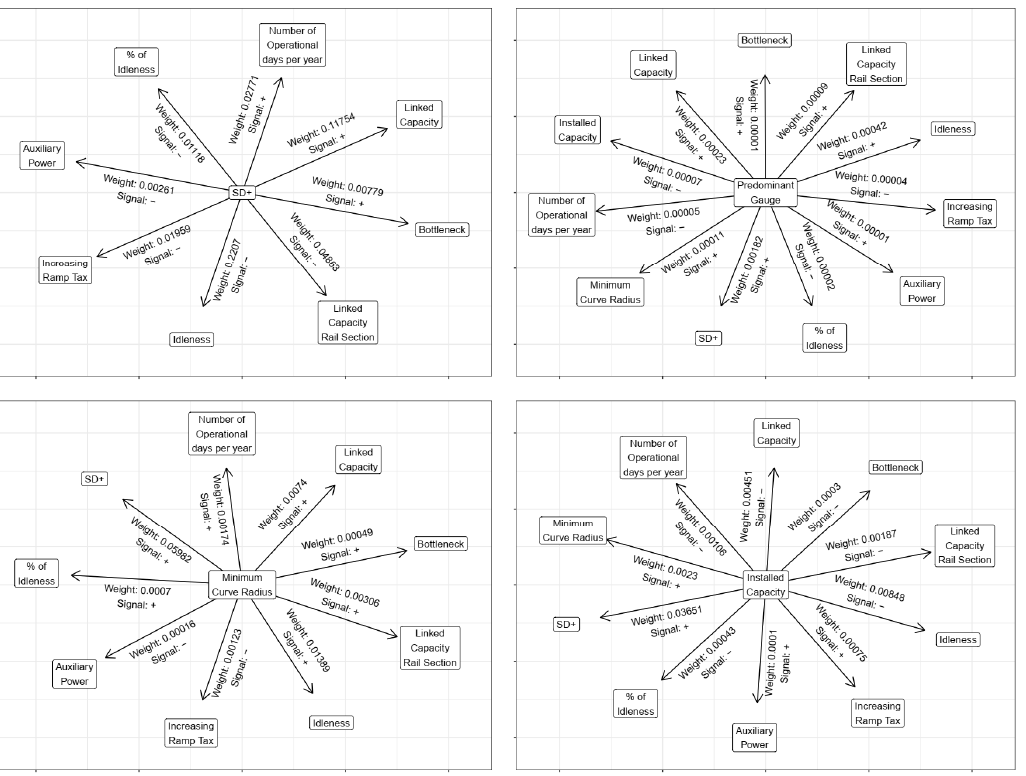
Figure 10. Cause and effect framework for selected attributes at 0.975 percentile (weights are derived from step 2, signs are derived from Olden and Jackson’s (2002) [48] sensitivity analyses).